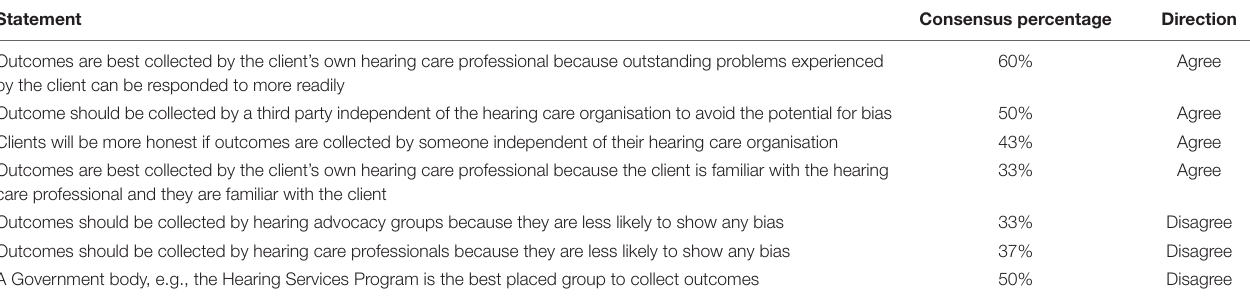
TABLE 7 | Statements from the parties responsible for collection section among the professional